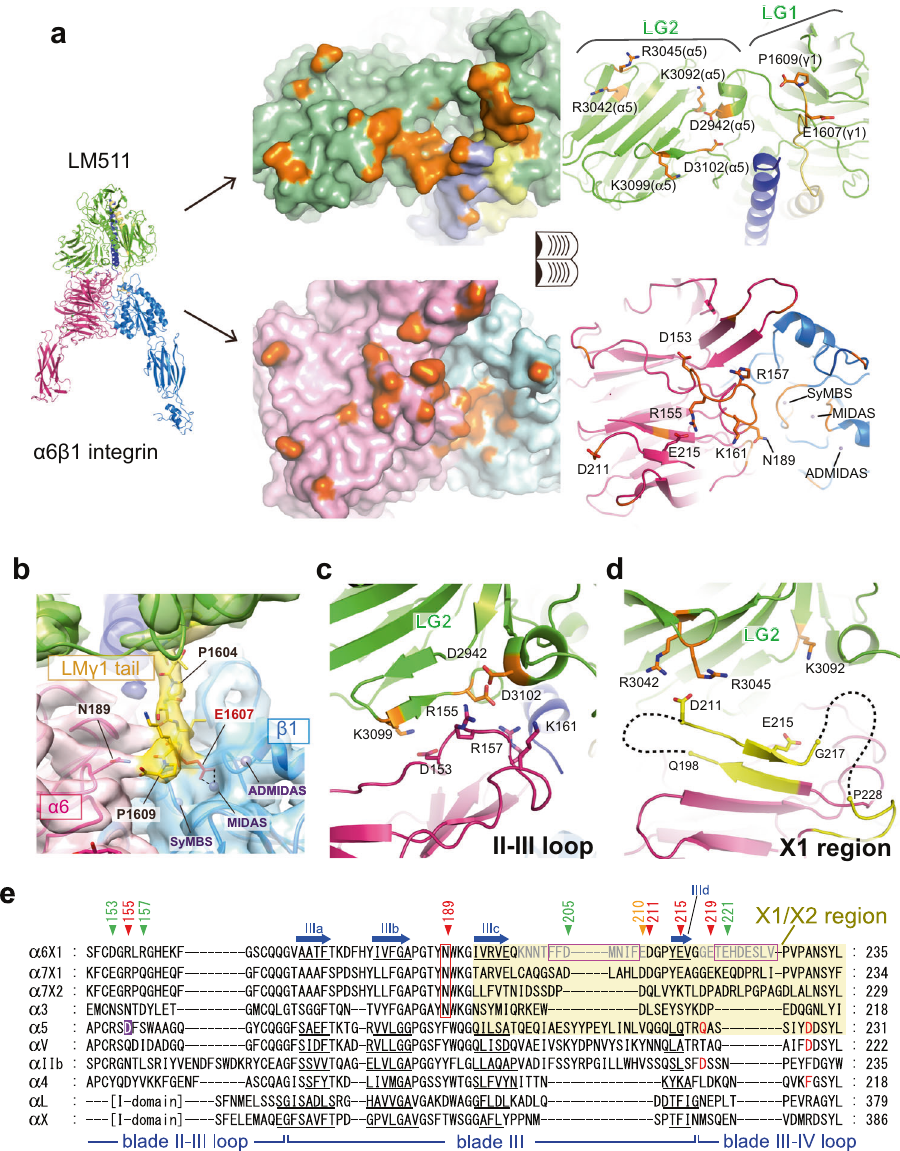
Fig. 5 Interaction between α 6 β 1 integrin and LM511. a Open book view of the binding interface. (Left) Surface representations. Atoms in contact with the partner molecule (within 4 Å) are shown in orange. (Right) Cartoon representations. The key residues in this paper are shown as stick models and labeled. The surface and the cartoon fi gures are viewed from the same orientation. b Cryo-EM map near the laminin γ 1-tail, drawn at the contour level of 0.05 in Chimera. The atomic model of the γ 1-tail region (T1603-P1609) is shown in yellow stick model. Note that E1607 (red stick model) in the γ 1-tail is in a suitable position to coordinate MIDAS cation and that the terminal carboxyl group of P1609 is pointing toward N189 of integrin α 6 subunit. Close-up views for the contacts between the laminin LG2 domain and the II-III loop region c or the X1 region d of the α 6 β -propeller domain. e Multiple sequence alignment of integrin α subunits for blade III and its fl anking loop regions. Positions for the four β -strands constituting the blade III (strands IIIa-IIId) are denoted by blue arrows above the alignment, and the actual β -strand segments in each structurally determined α subunit are underlined. The Asn189 conserved in all laminin-binding integrins and the segments that are truncated in α 6 mutants used in Fig. 6f are boxed in red and magenta, respectively. The α 6 residues mutated for the functional study shown in Fig. 6 are labeled on top of the alignment, color-coded according to their fold reduction in the laminin af fi nity when mutated to Ala by red (>10-fold), orange (5 – 10 fold), and green (<5-fold). See also Fig.